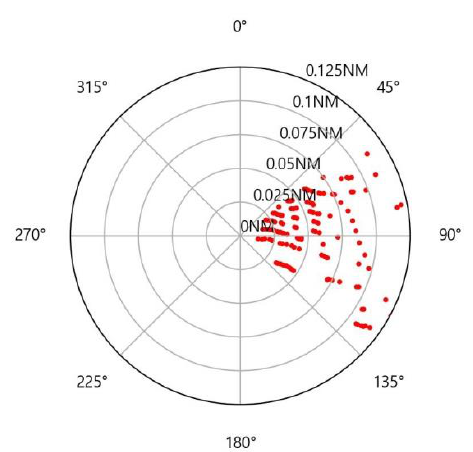
Figure 22. Radar screen (Experiment B).